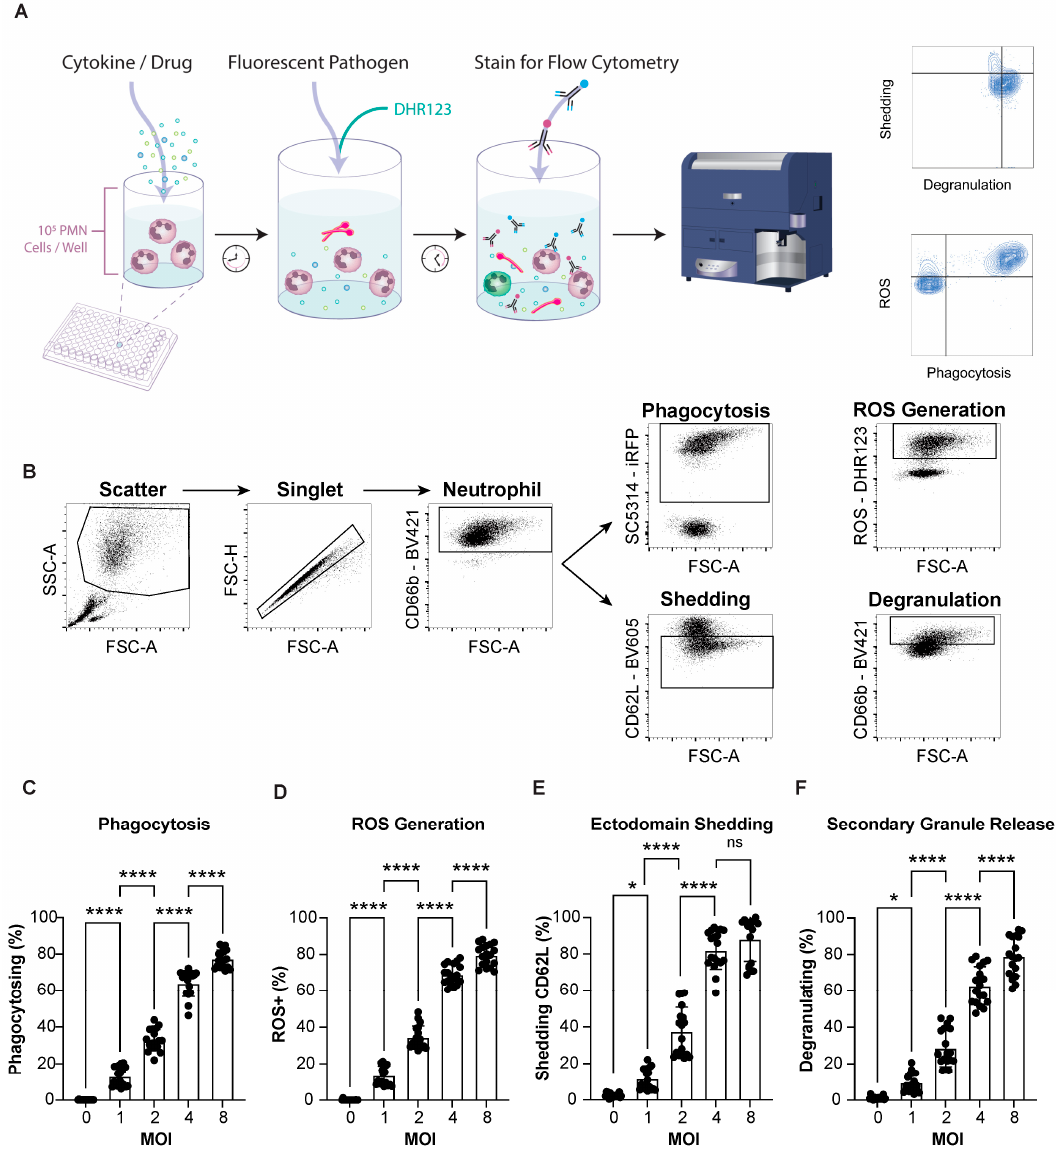
Figure 2. Multiple neutrophil functions can be measured using a multiparametric flow assay. ( A ) Schematic representation of assay workflow. Neutrophils are incubated with cytokines or drugs Figure 1. Phylogenetic gain/loss tree of TP53 gene (created in www.ensembl.com on 17/12/2022 ). prior to the addition of ROS detection dye DHR123 and co-culture with iRFP expressing fungal The tree shows the number of TP53 paralogues/copies for each species or taxon. Red lines mark pathogen C. albicans . After co-incubation, neutrophils are immunostained for the detection of significant expansion of the TP53 gene copies.